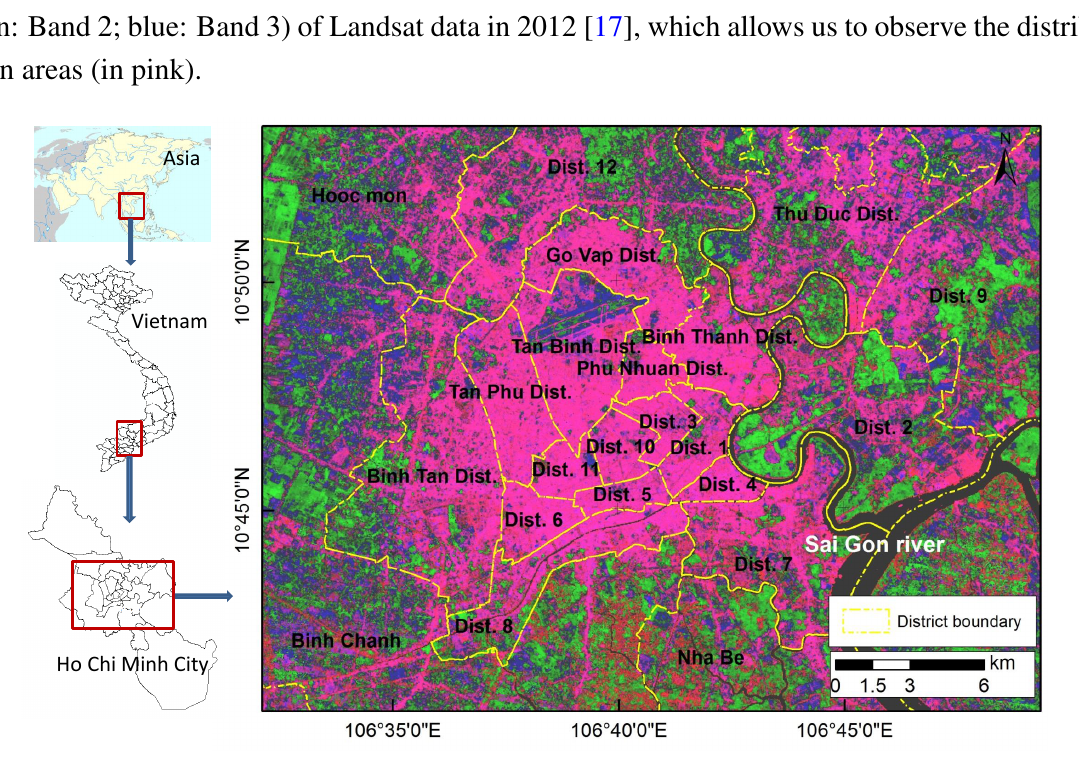
Figure 1. The study area is Ho Chi Minh City (HCMC) covering about 25 km × 30 km. The background image is the composite display (red: Band 1; green: Band 2; blue: Band 3) of Landsat data in 2012 [17], which allows us to observe the distribution of urban areas (in